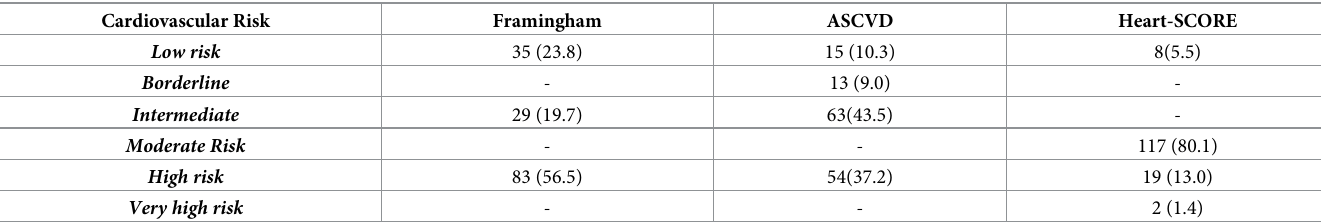
Table 3. Cardiovascular risk